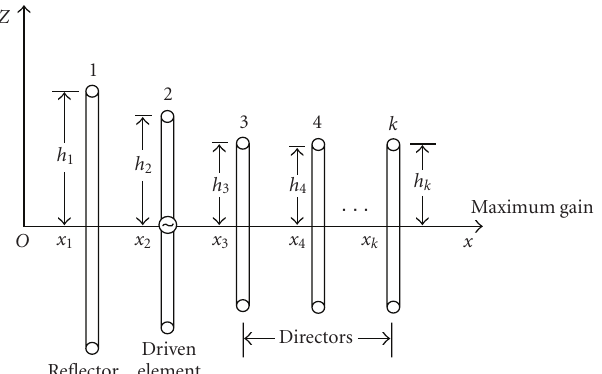
Figure 1: Geometry of a K element Yagi-Uda array.